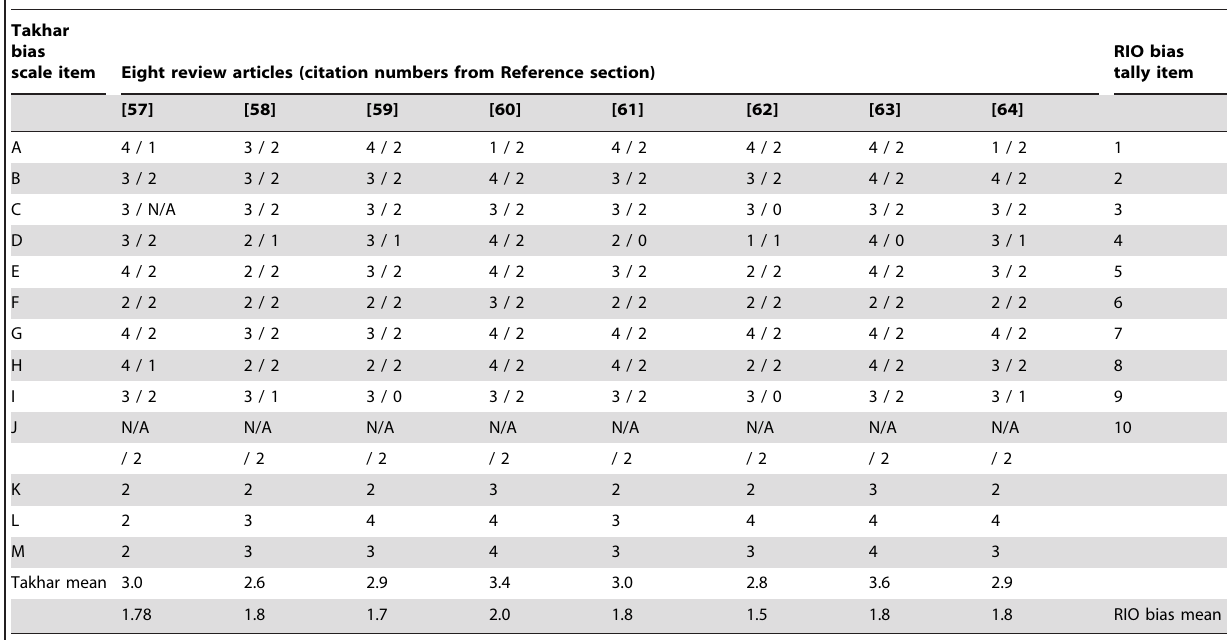
Table 3. Bias in eight rimonabant review articles.